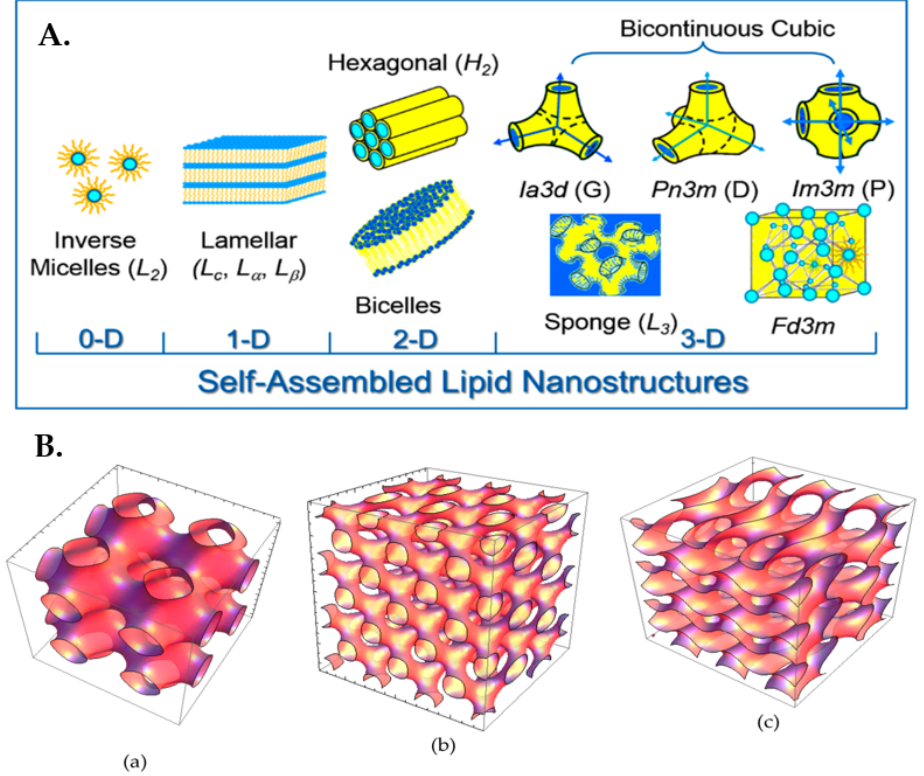
Figure 2. ( A ) Thermodynamically stable self-assembled lipid nanostructures. Adapted from Kulka- rni [3]. ( B ) Three-dimensional organizations of cubic liquid crystalline phases: ( a ) primitive cubic ( Im3m /Q IIP ), ( b ) bicontinuous double diamond cubic ( Pn3m /Q IID ), and ( c ) bicontinuous gyroid cubic ( Ia3d/ Q IIG ) types. Adapted from Rakotoarisoa et al.